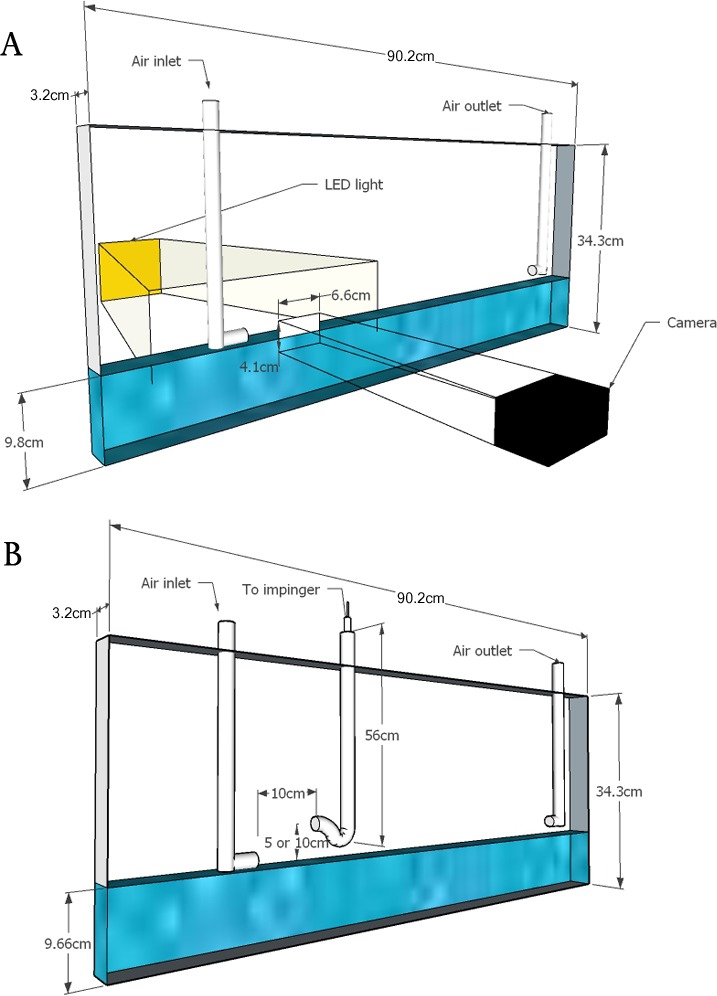
Schematic of flumes used in laboratory experiments.Schematic showing the experimental design of Flume A for imaging experiments (A) and Flume B for experiments to monitor the transport of P. syringae (B). For Flume A, the camera viewed an area of 6.6 cm by 4.1 cm at the air-water interface. For both flumes, the air outlet was connected to a vacuum which pulled air across the water surface and the air inlet allowed air to enter the system.